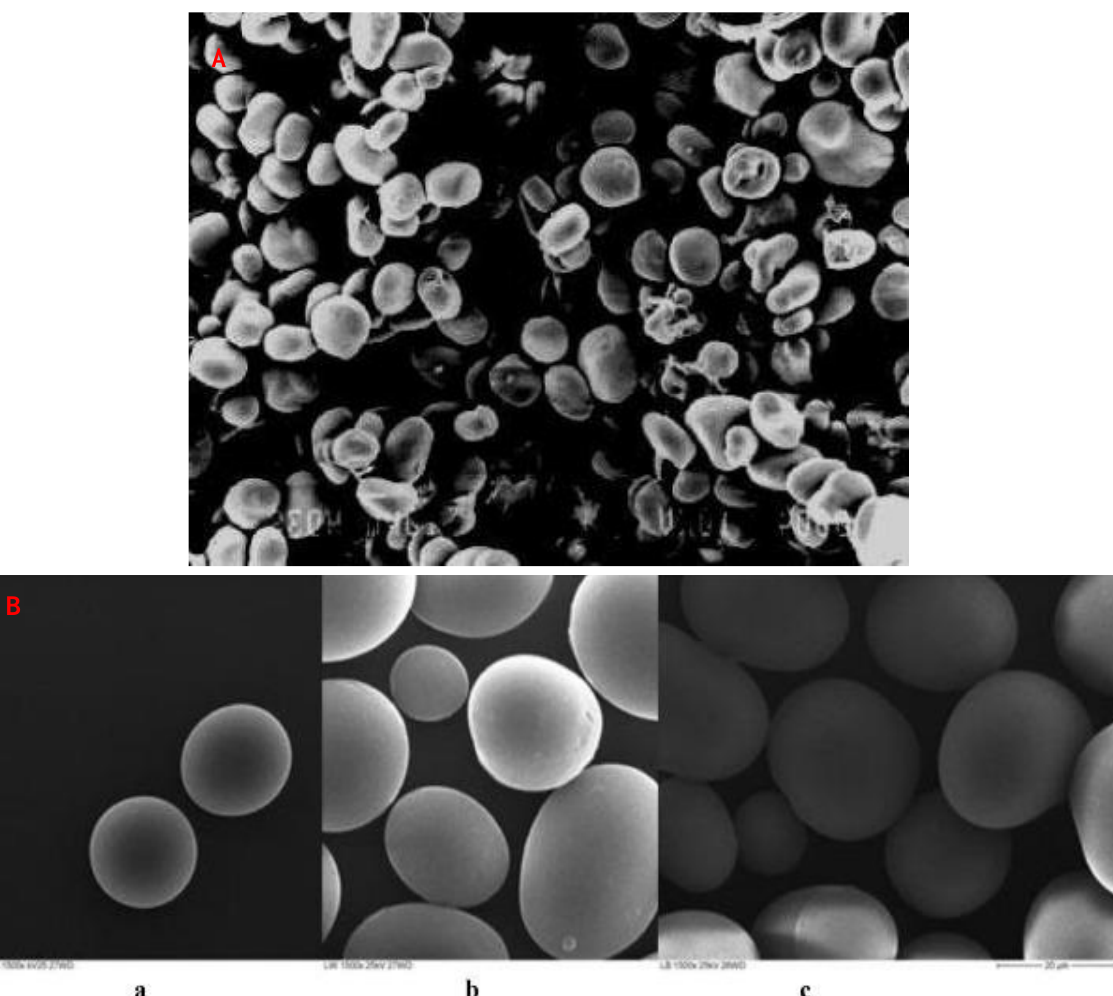
Figure 3. ( A ): Scanning electron microscope of lima bean starch at 200 × magnification [73]. ( B ): Scan- Figure 3. ( A ) : Scanning electron microscope of lima bean starch at 200× magnification [73]. ( B ): Scan- ning electron microscope of lima bean starches at 1500 × magnification ( a ) red native starch ( b ) white ning electron microscope of lima bean starches at 1500× magnification ( a ) red native starch ( b ) white native starch ( c ) brown native starch native starch ( c ) brown native starch [74].